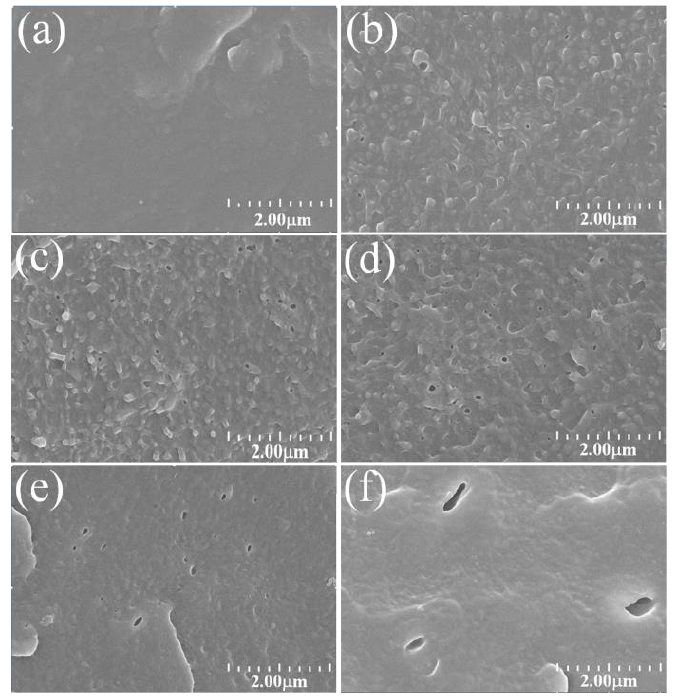
Figure 3. SEM images of Ac-SEBS/PE composites with different acetylation degrees of SEBS: ( a ): polyethylene (PE), ( b ): 1.2%; ( c ): 9.3%; ( d ): 10.2%; ( e ): 18.9%; ( f ):